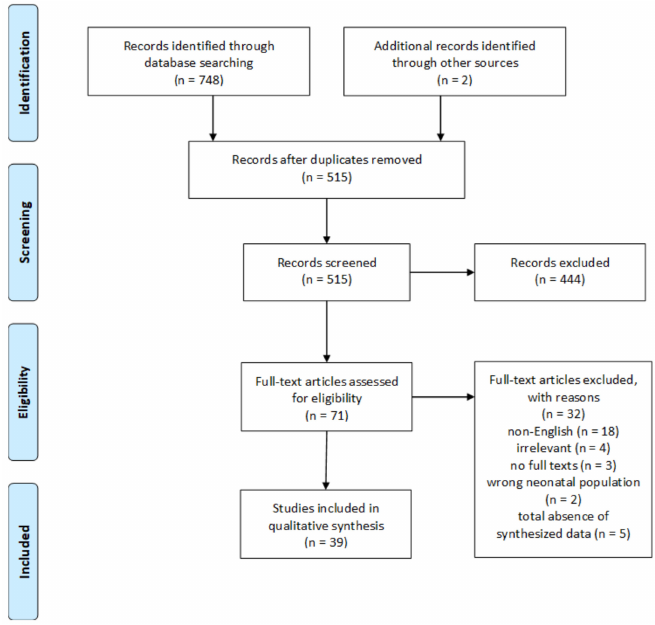
Figure 1. Flow diagram of the